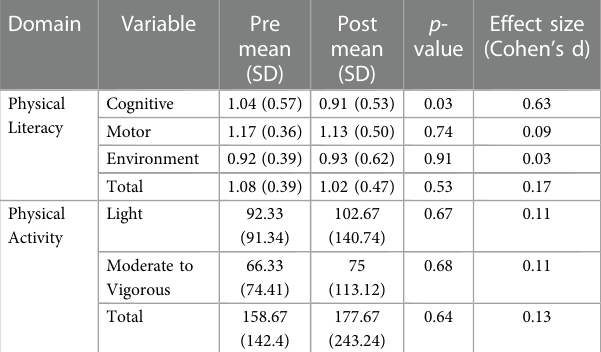
TABLE 3 Change in physical literacy and physical activity from pre- to post-intervention.